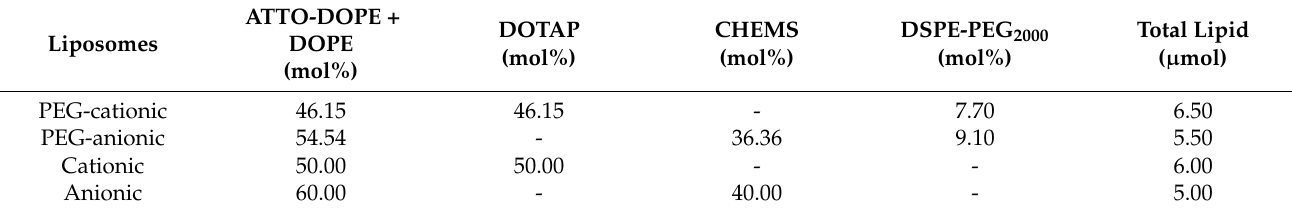
Table 1. Lipid composition of various liposomes by